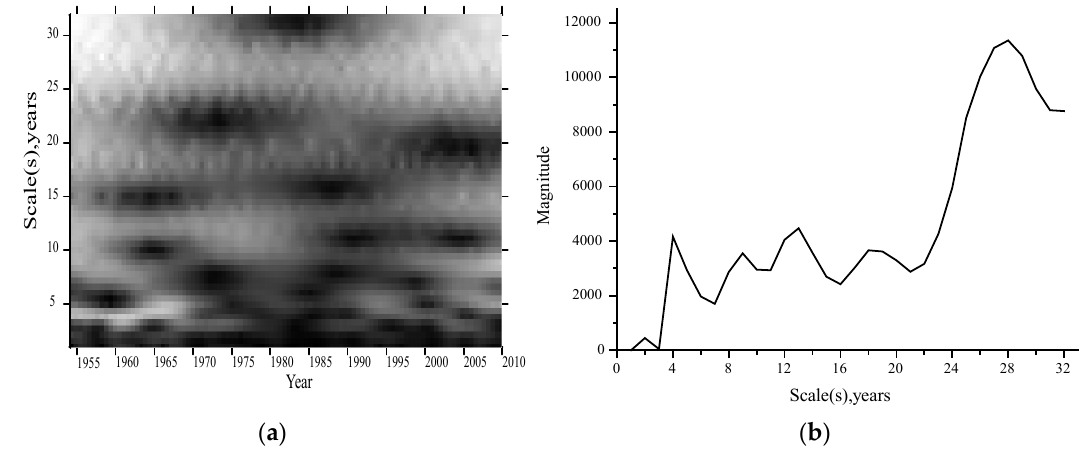
Figure 15. Continuous wavelet spectrum ( a ) and global wavelet spectrum ( b ) of the annual total precipitation series.